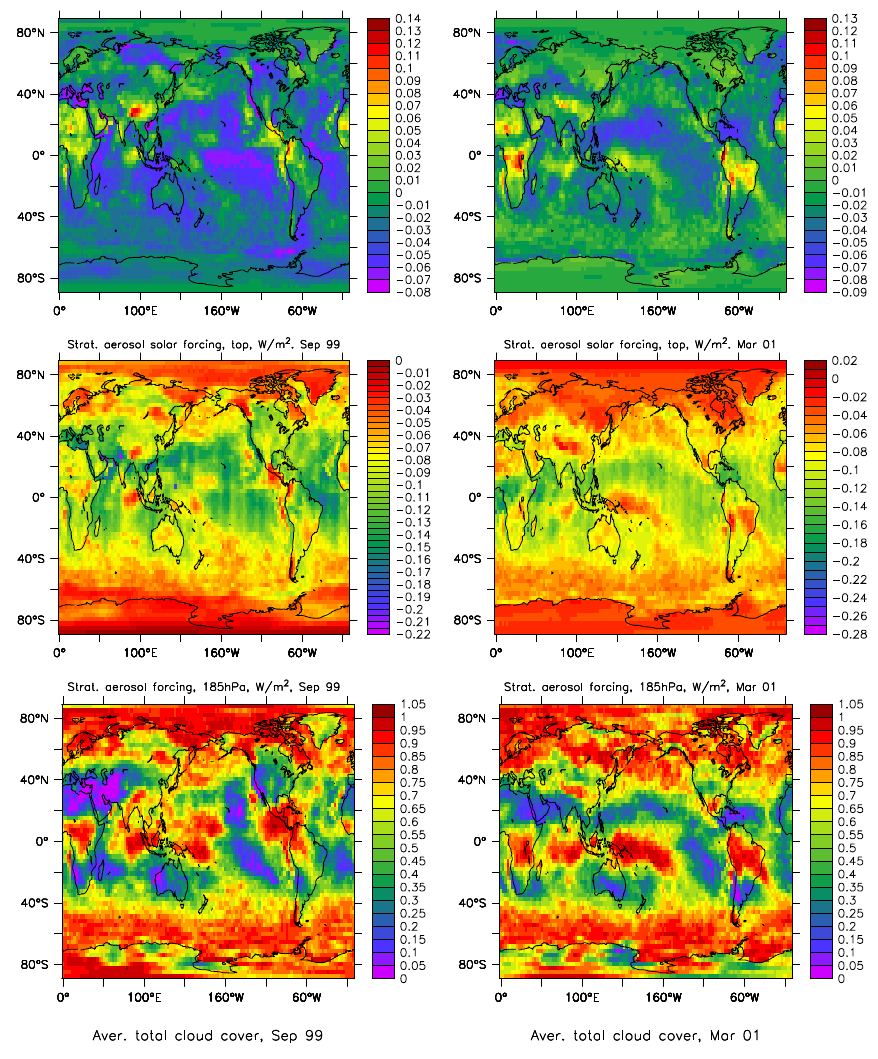
Fig. 9. Solar radiative forcing of stratospheric aerosol (above 110hPa) at the top of the atmosphere (upper panels) and at 185hPa (middle panels). The lower panels show the average total effective cloud cover in the